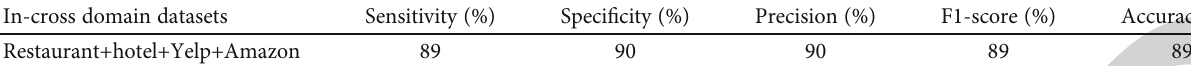
Table 3: Classi fi cation results for cross-domain experiment.